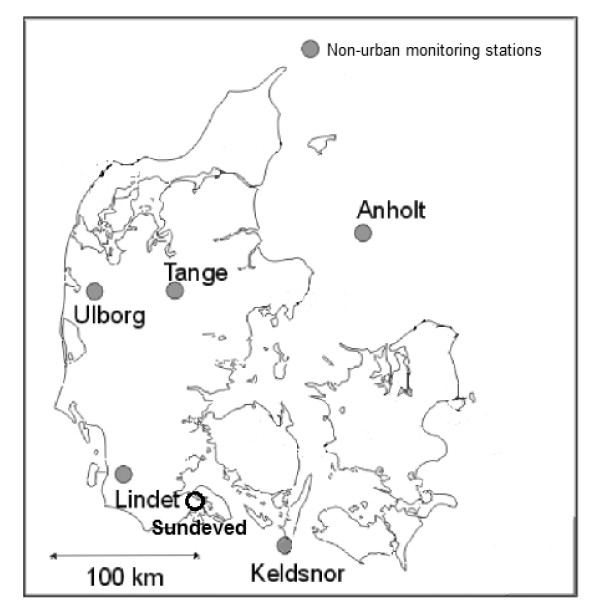
Danish air quality monitoring stations: Anholt (Region I), Ulfborg (Region II), Keldsnor (Region III), Tange (Region IV) and Lindet (Region V). Location of Sundeved (Region VI).